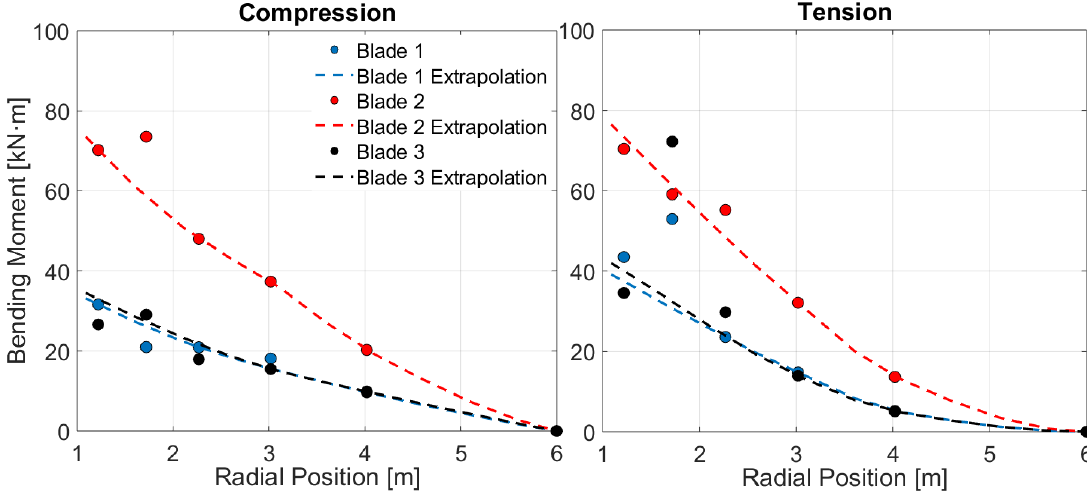
Figure 5. Blade root bending moment extrapolation procedure for one instance in